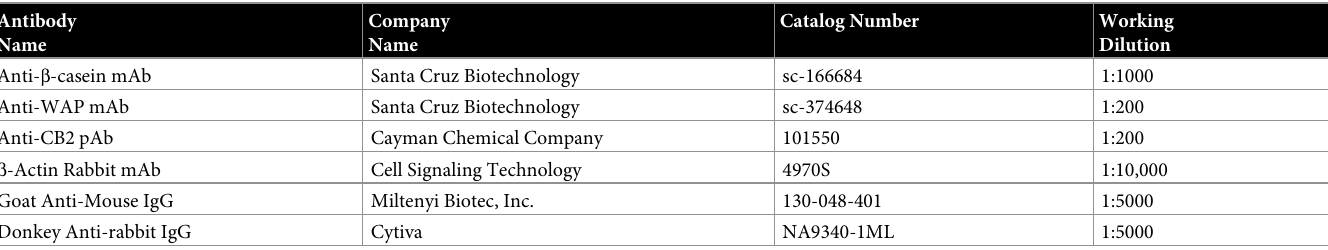
Table 2. List of primary and secondary antibodies used in this